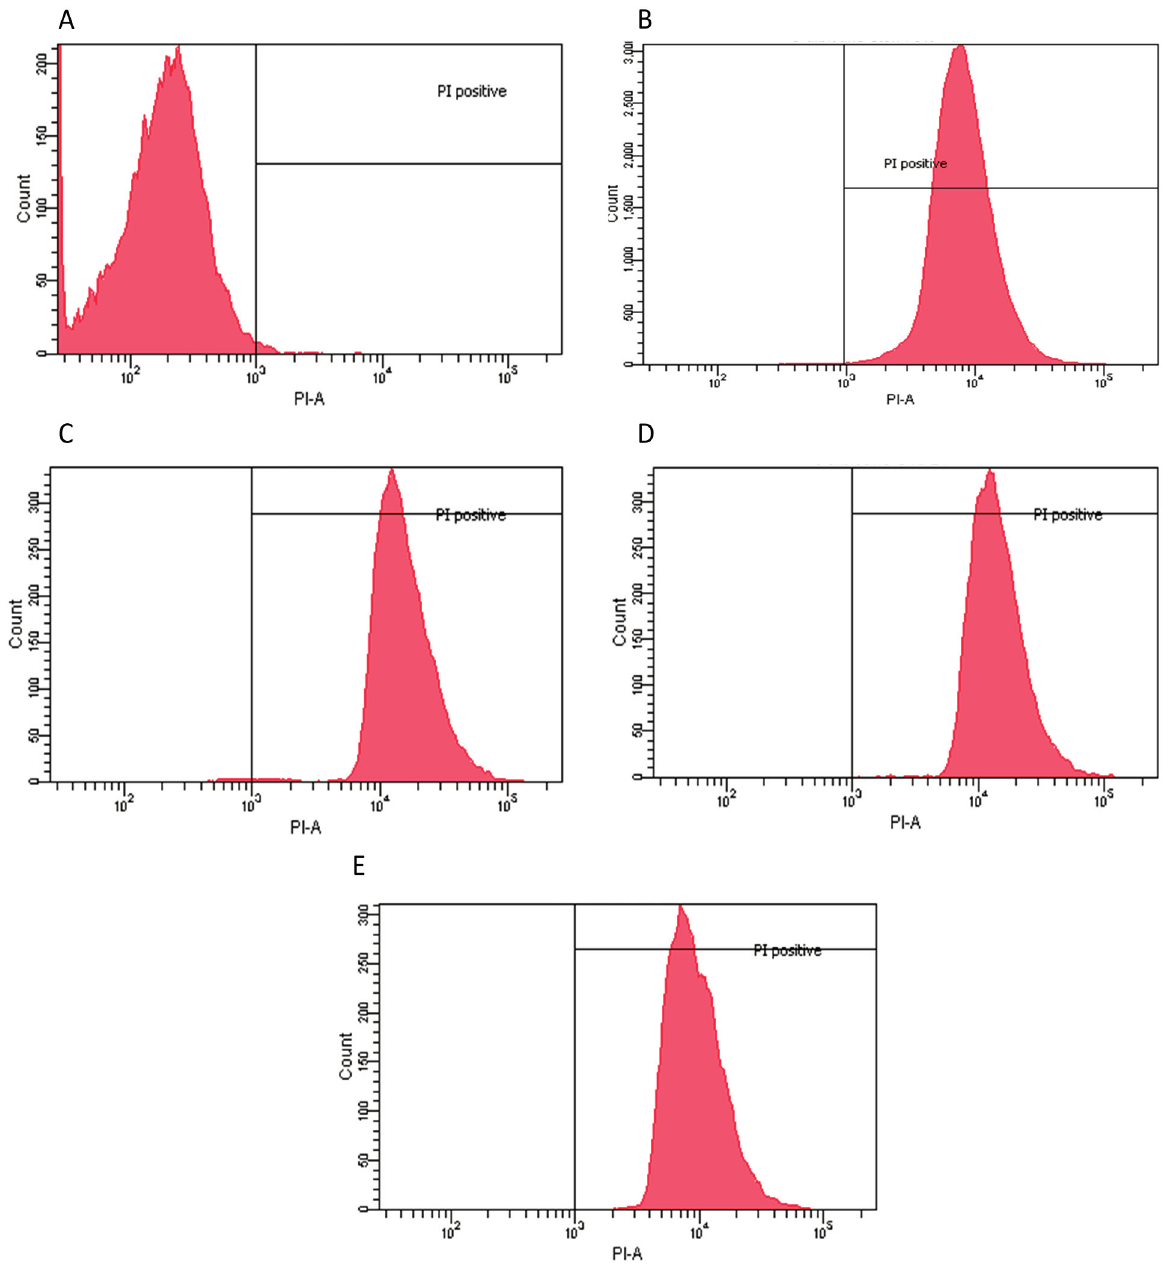
Figure 5. Flow cytometry histograms derived from scatter plots showing fluorescence of live (<103) or dead (>103) of C. albicans stained with PI post 24 h incubation with controls or extracts. X-axis corresponds to the PI positive marked microorganisms and Y-axis to the total cell count. ( A ) C. albicans sample PI negative control, 99.8% viability; ( B ) C. albicans incubated for 30 min with ethanol 70% PI positive control 0.1% viability; ( C ) water dry leaf non-boiled extract 1 μ g/mL, 0.6% viability; ( D ) methanol 1 μ g/mL, 0.1% viability; and ( E ) water non-dried leaves non-boiled 1.5 μ g/m, 0.2%